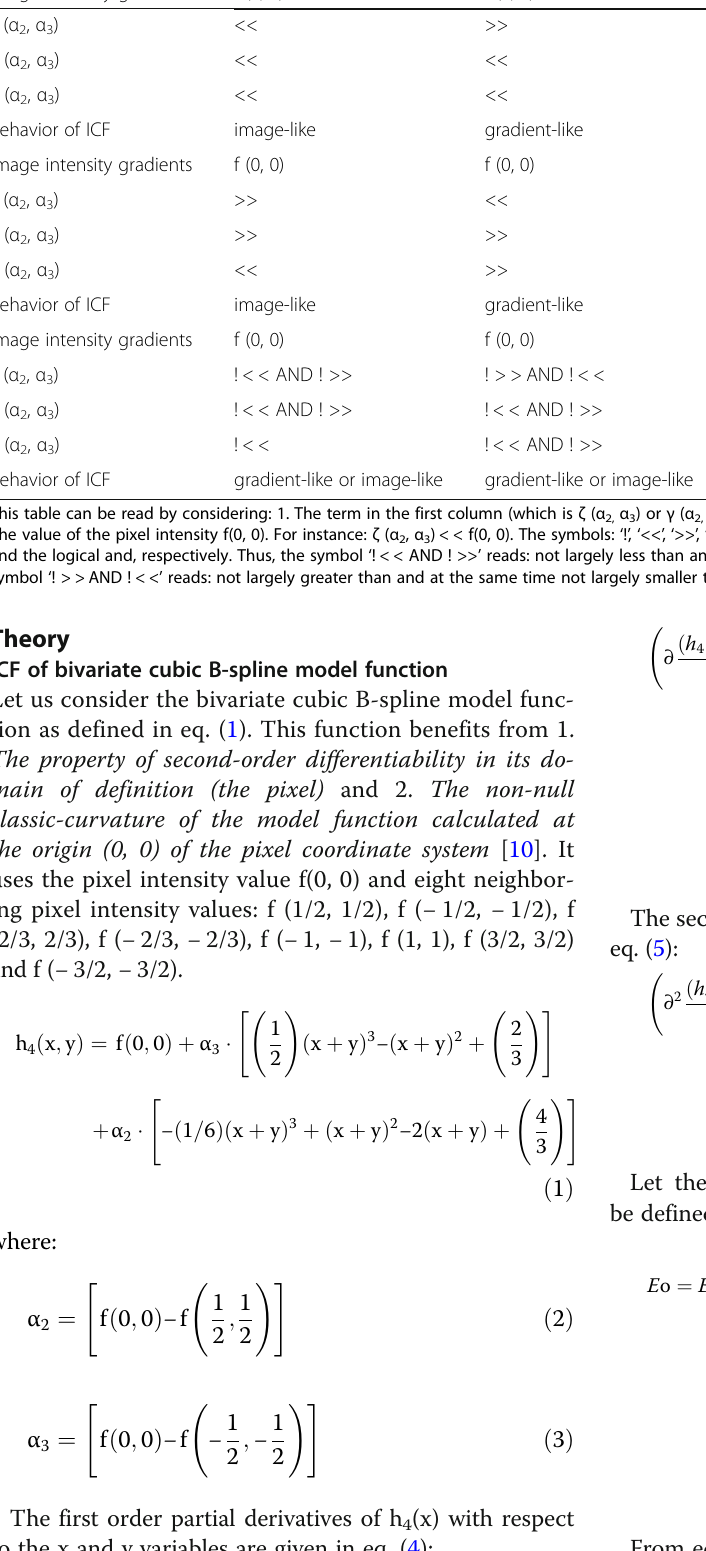
Table 1 Characterization of intensity-curvature functional Image intensity